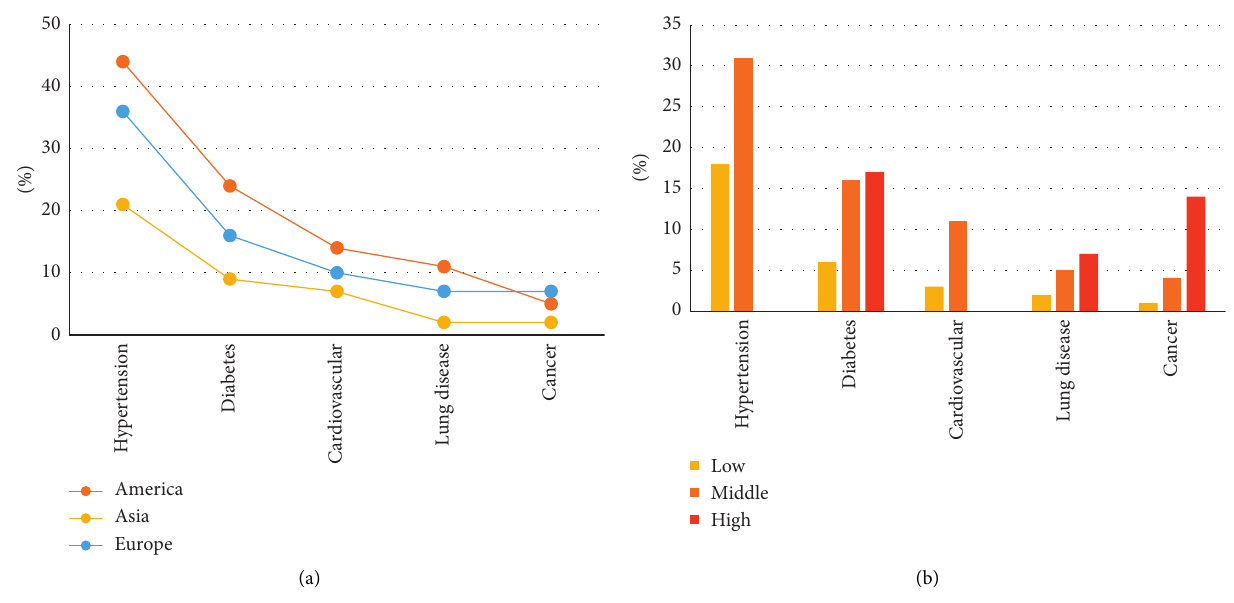
Figure 3: Comorbidities of COVID-19 patients in different